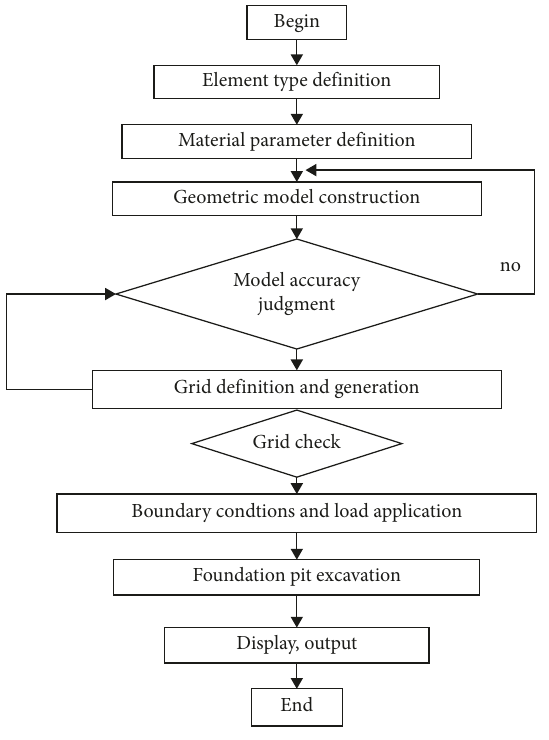
Figure 1: Calculation flow